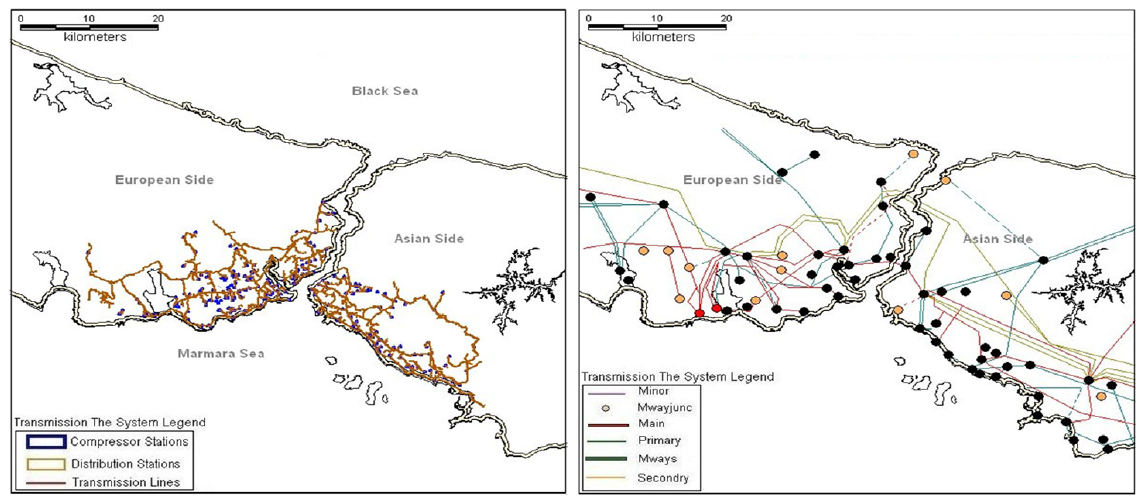
Figure 13. Natural gas transmission network (left) and electricity network (right) with a uniform, 600m-width buffer zone which corresponds to 2 Fig. 13. Natural gas transmission network (left) and electricity network (right). A uniform, 600m-width buffer zone which corresponds to the maximum inundation distance from the coastline (adopted from KOERI, 2002). 3 the maximum inundation distance from the coastline is also shown (modified after KOERI,